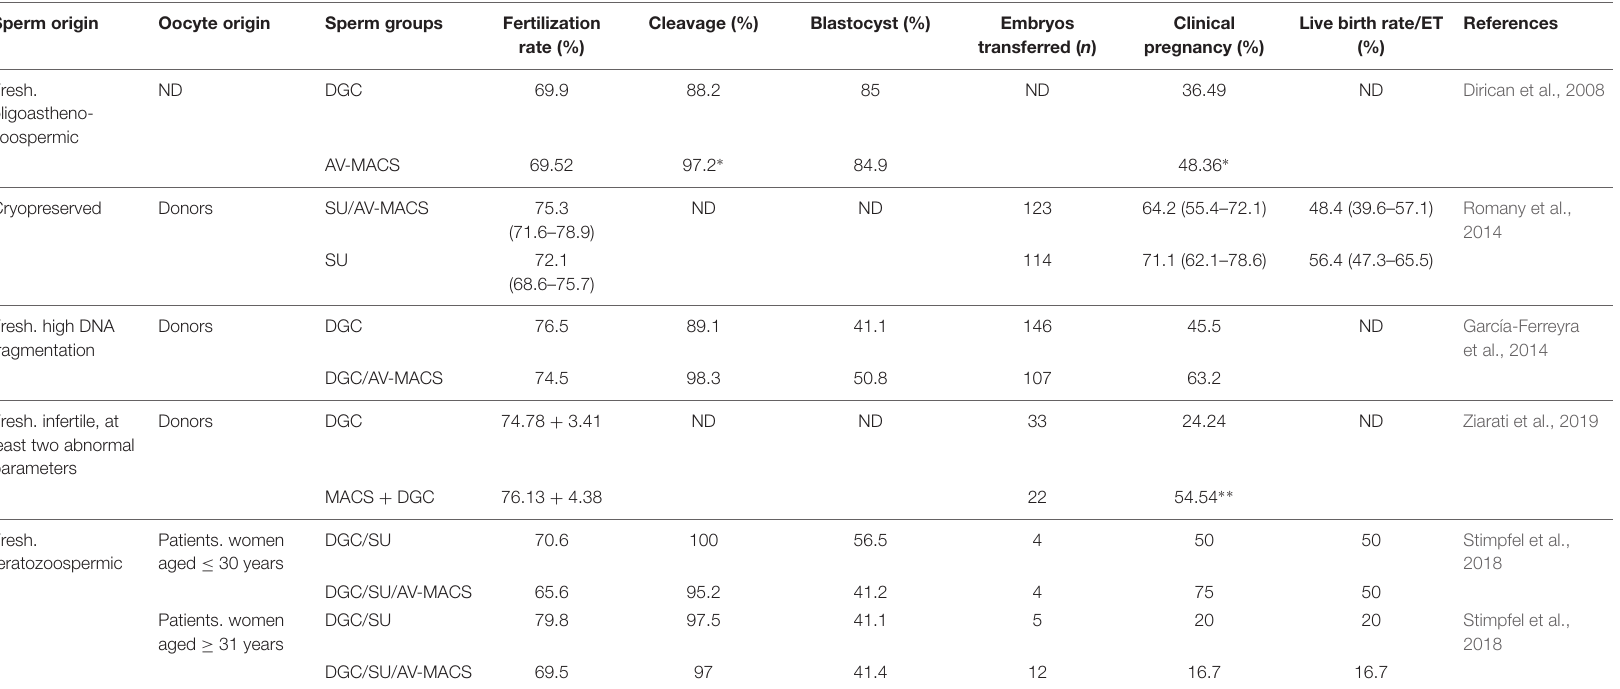
TABLE 2 | Reproductive outcomes of ARTs employing spermatozoa selected by